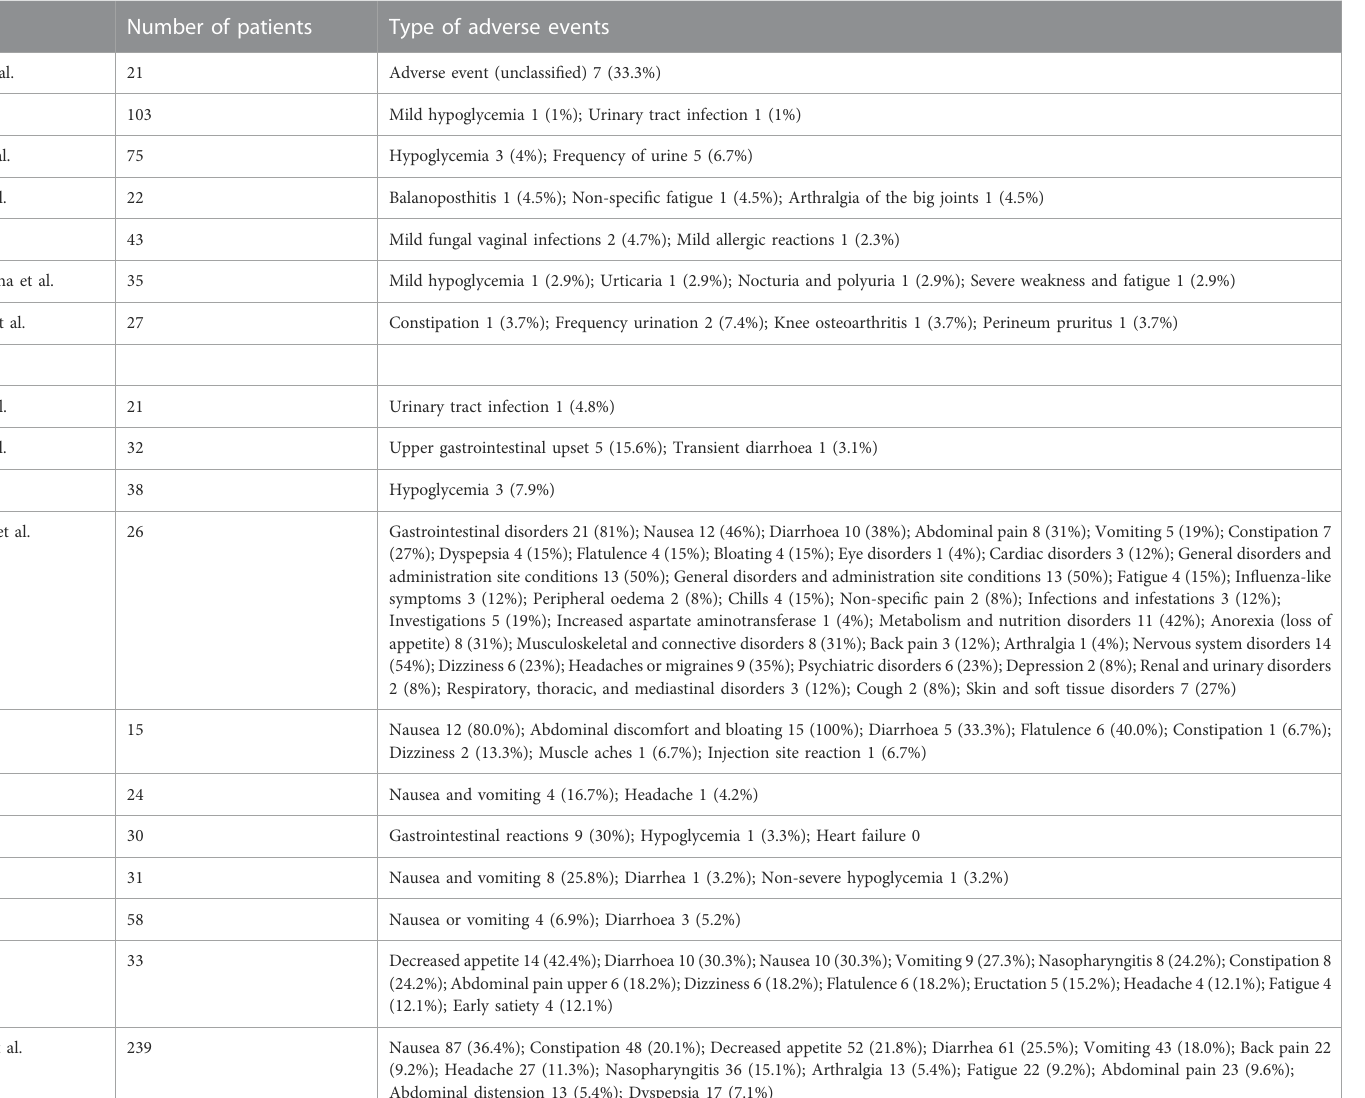
TABLE 2 Summary of adverse